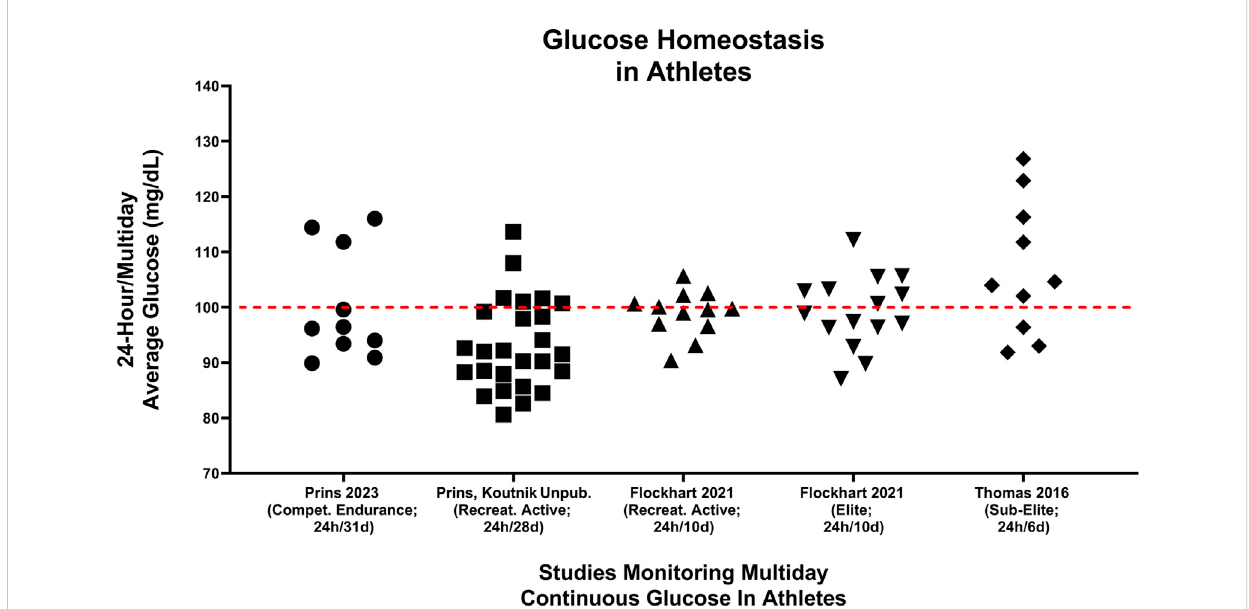
FIGURE 7 Multiday averages of minute-by-minute continual glucose monitoring from 73 athletes of different fi tness calibers are presented across 5 different studies (Thomas et al., 2016; Flockhart et al., 2021; Kulawiec et al., 2021; Prins et al., 2023a) (Prins, Koutnik unpublished). (Thomas et al., 2016) median glucose values were captured cumulative distribution plots of the entire averaged continuous glucose signal over the 6-day period (Figure 5; 0.5; (Thomas et al., 2016)). Prins, Koutnik unpublished data represented continuous glucose values from recreationally athletes over a 4-week duration [cohort: (Bugaetal.,2023)].Median[(Thomasetal.,2016;Prinsetal.,2023a)Prins,Koutnikunpublished]ormean(Flockhartetal.,2021)multidayaverage glucoses values were presented. Red line differentiates individual athlete ’ s 24 h blood glucose averages above and below 100